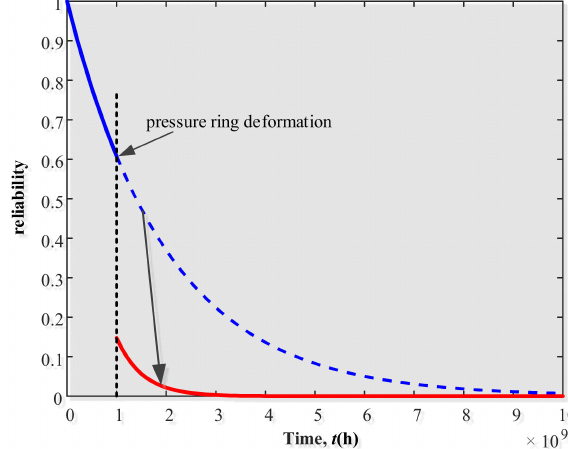
Figure 10. Reliability of subsea wellhead connector when pressure ring deformation occurs at t = 10 9 h.